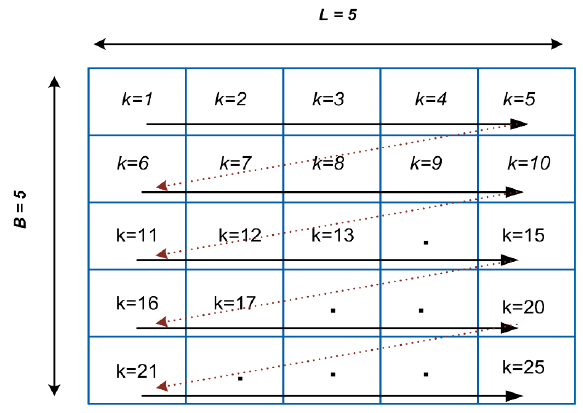
Figure 4. Scanning order to get index k for an image of size 5 × 5.